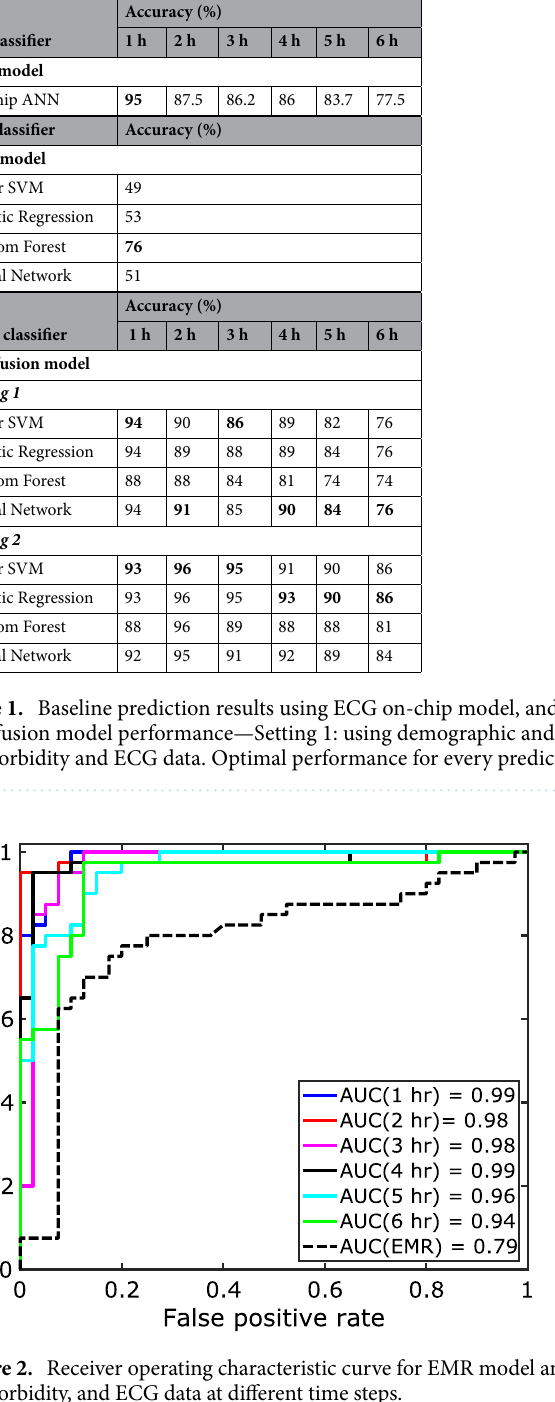
ECG data; setting 2 : late fusion was performed using demographic, co-morbidity, and ECG data. Late fusion was performed for 1 h to 6 h before the sepsis onset time. Figure 2 shows the area under the receiver operating characteristic curves (AUROC) for late fusion model using demographic, co-morbidity, and ECG data at dif- ferent time steps.